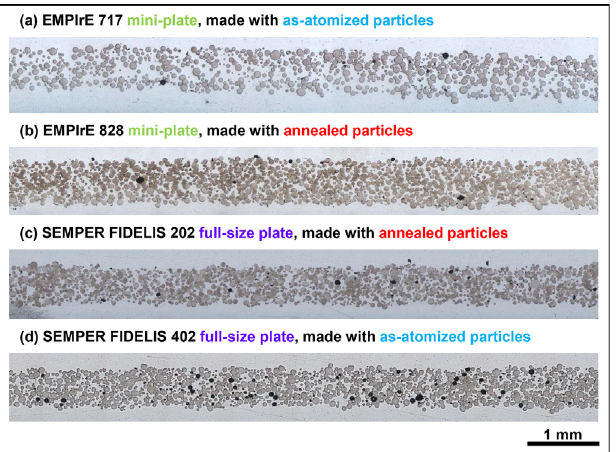
Fig. 2. OMmacrographsof(a)EMP-717,(b)EMP-828,(c)SF-202, (d) SF-402